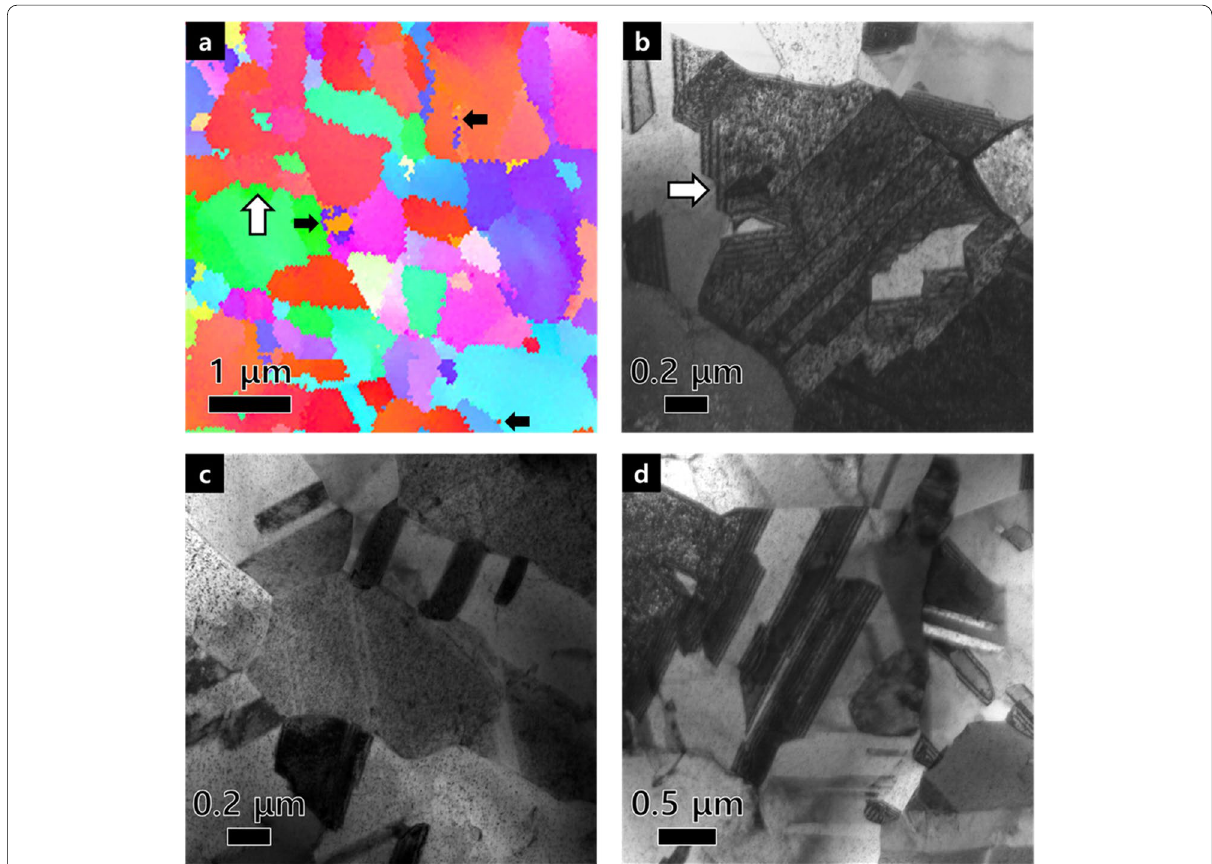
Fig. 4 a EBSD IPF map after grain dilation. b - d TEM image of copper foil in plane